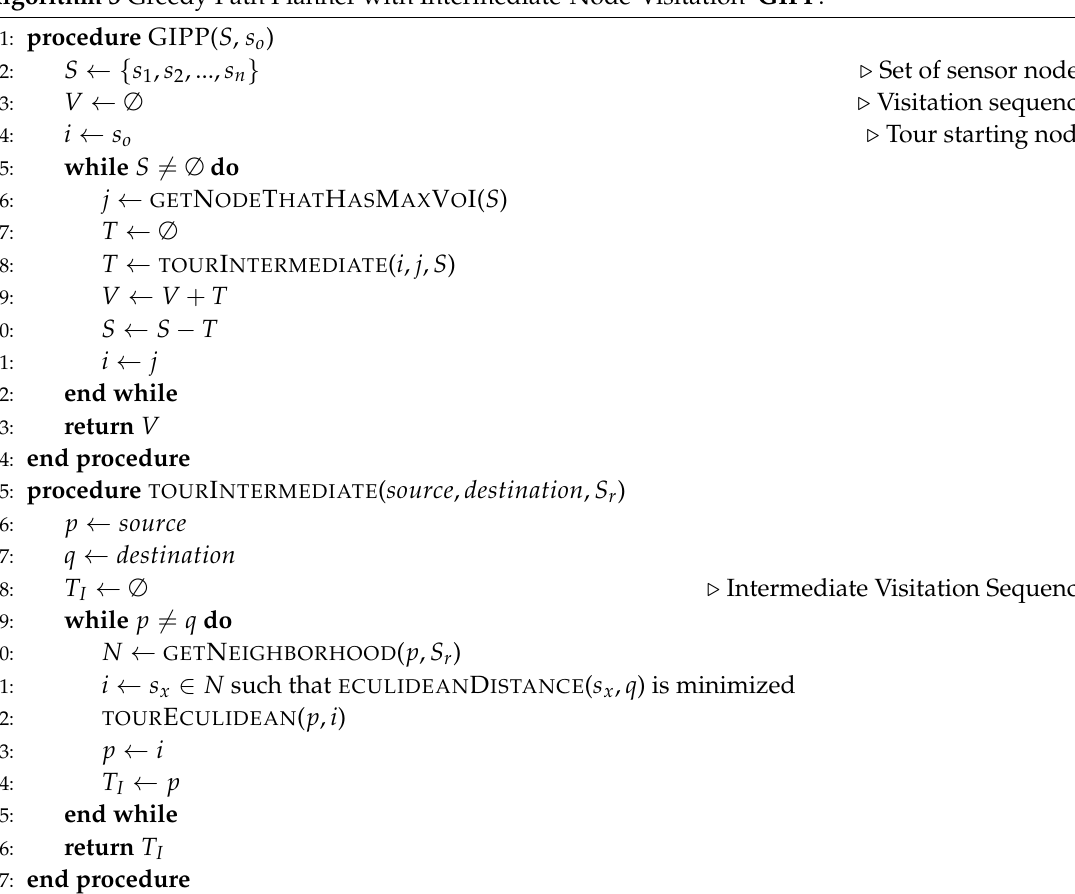
Algorithm 3 Greedy Path Planner with Intermediate-Node-Visitation– GIPP .